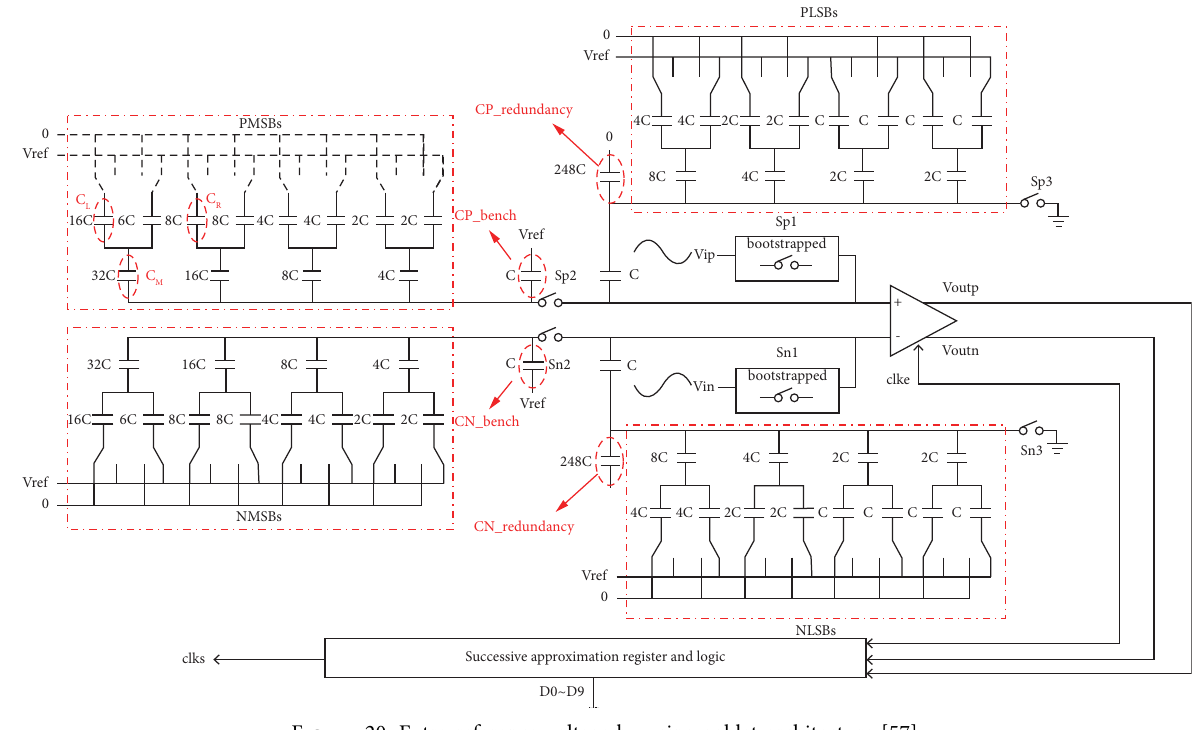
Figure 20: Extra reference voltage by using goblet architecture [57].